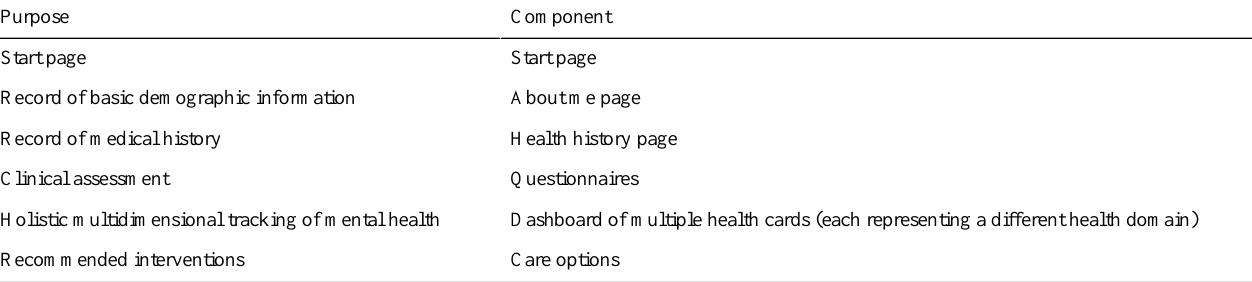
Table 1. Key components of the Brain and Mind Youth